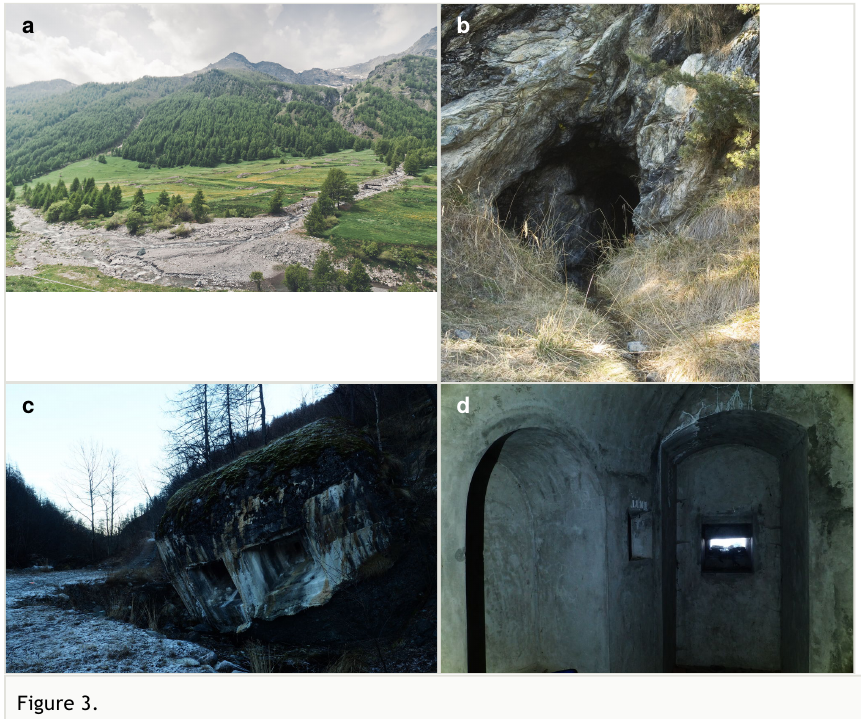
Figure 3. Habitats of Pimoa delphinica . [Photo credit: a) Simone Spedicato; b-d) Alessandro Girodo] a : The typical alpine environment in the high Varaita valley where the caves colonized by Pimoa delphinica are